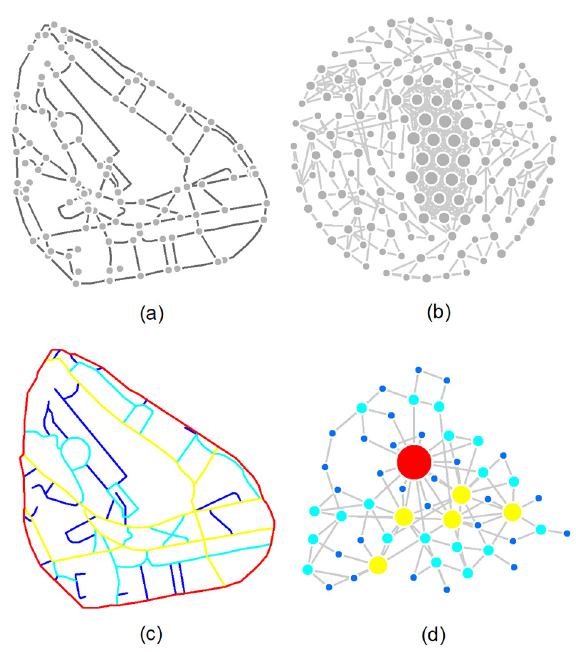
Figure 2. (Color online) Transformation from segment–segment topology to street–street topology. (Note: From the network perspective of street segments and streets, segment–segment topology (Panels a and b ) is a mechanistic structure that lacks the scaling pattern of far more smalls than larges, whereas the street–street topology (Panels c and d ) is organic, as it holds such a pattern clearly).